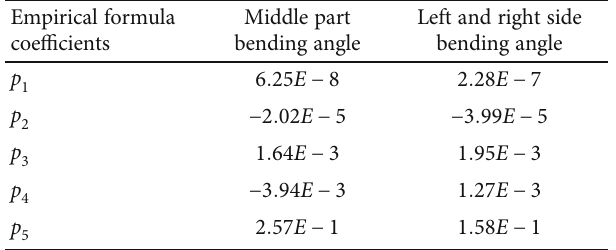
Table 4: Empirical formula coe ffi cients of P ‐ Φ characteristic curves.